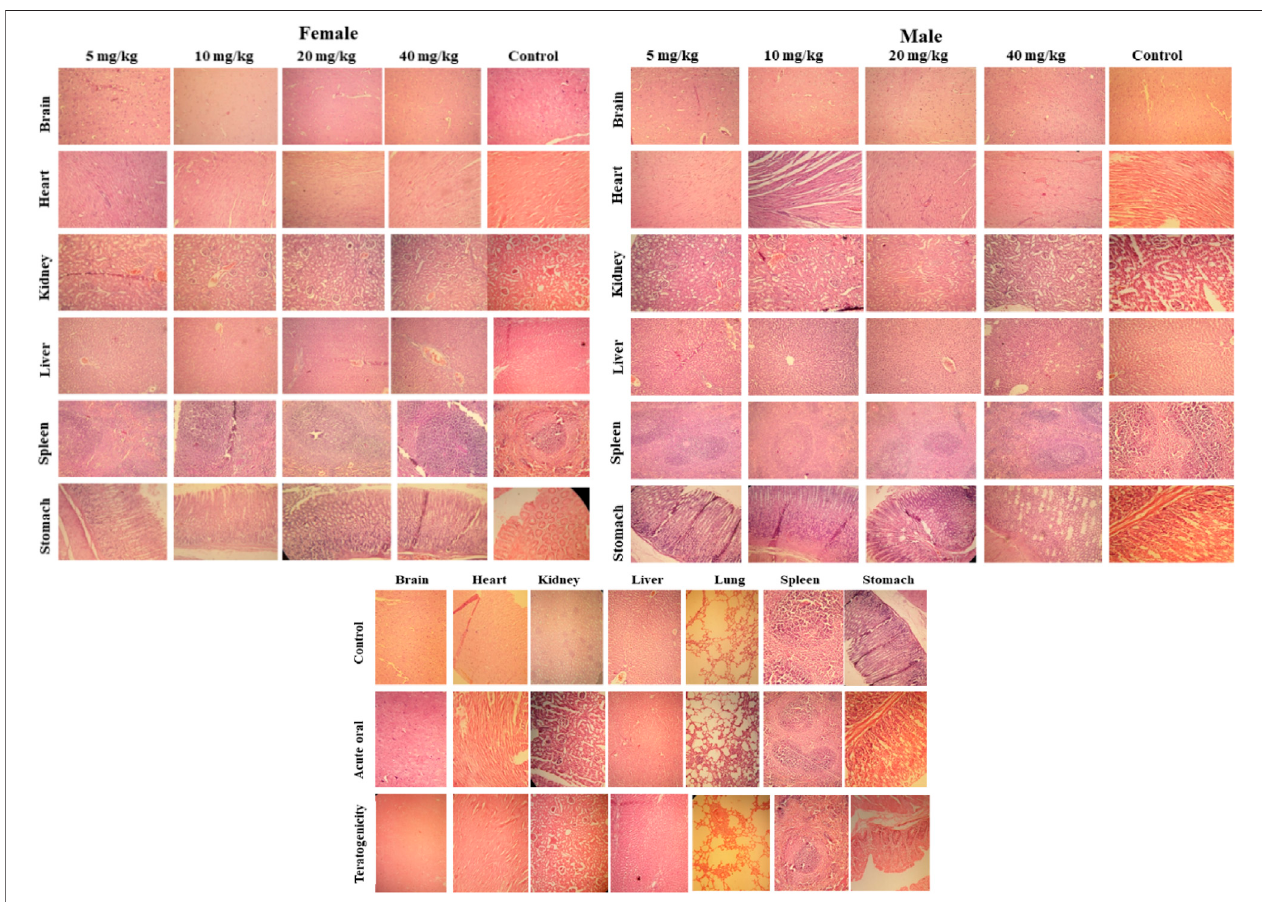
FIGURE 8 | Histopathological examination of selected tissues (using hematoxylin and eosin staining) of rats treated with SF1 in subacute toxicity (at 5, 10, 20 and 40 mg/kg), acute oral toxicity (2000 mg/kg), and teratogenicity (40 mg/kg). The results are presented in comparison to the control in all three dose regimes.